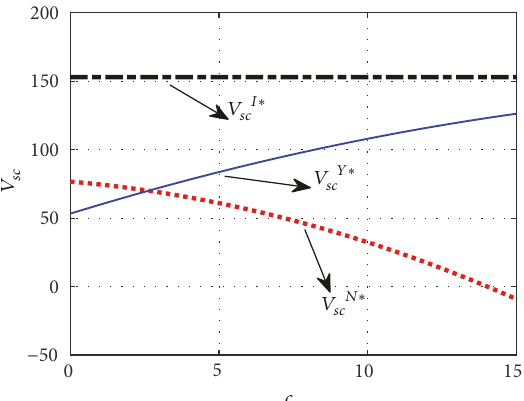
Figure8:Impactofthetransactionfeeonthelevelofmanufacturing resource sharing. Figure 9: Impact of the transaction fee on optimal profit.